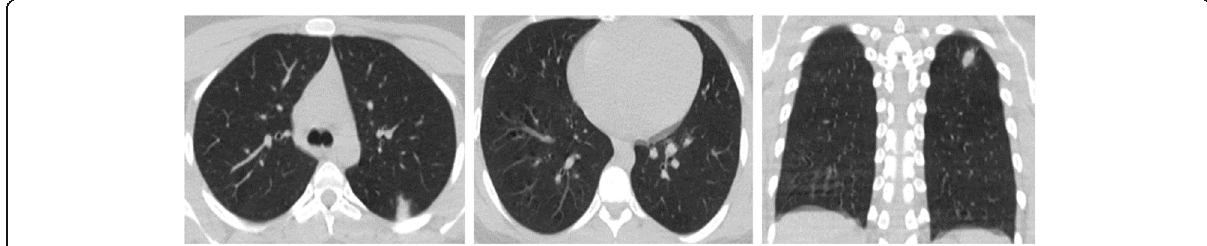
Fig. 6 Female patient, 32 years old, was complaining of dry cough and sore throat and was confirmed to be COVID-19 by RT-PCR. These axial and coronal non- contrast CT chest images (lung window) show fairly typical findings with moderate suspicion of COVID-19 pneumonia in terms of single peripheral ground-glass opacity within the left upper lobe with CORADS-2A. Left upper lobe has score 1 (with < 5% involvement), while the right upper, middle and both lower lobes show no involvement with score 0, so total CT lung severity score is 1 with 4% lung involvement denoting minimal grade of lung